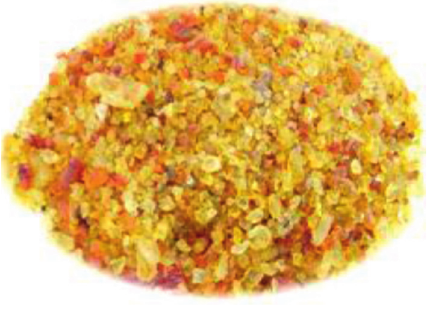
Figure 2: Khaya senegalensis gum. Table 1: Physicochemical properties of Khaya senegalensis gum.